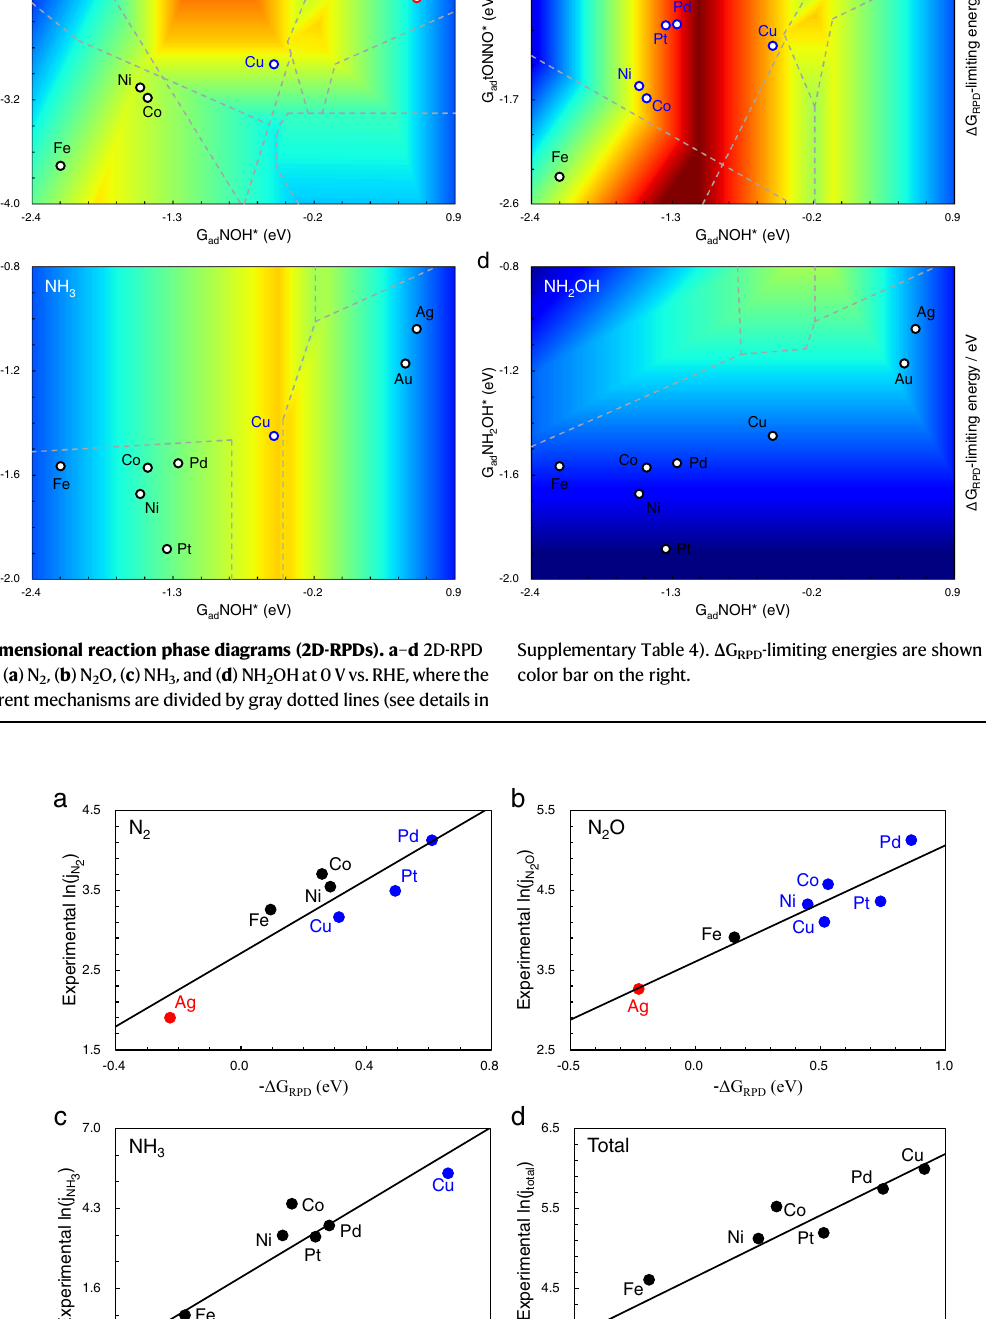
Fig. 4 | The comparison between theoretical descriptor ( − Δ G RPD ) and experi- mental activity 17 (ln( j i )) at 0V vs. RHE. a – c The comparison between computa- tional Δ G RPD -limiting energy and partialcurrent density of ( a )N 2 , ( b )N 2 O, ( c ) NH 3 .